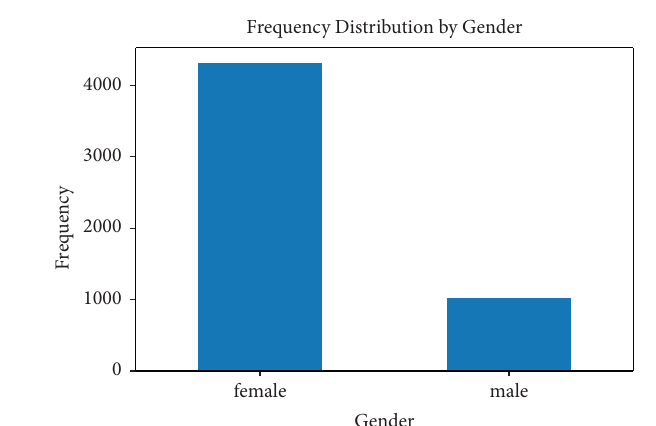
Figure 3: Frequency distribution by gender.